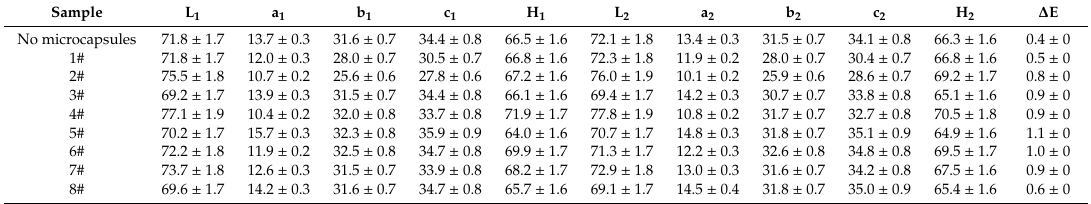
Table 3. E ff ect of the coating process on the color di ff erence of the paint film with microcapsules. Sample